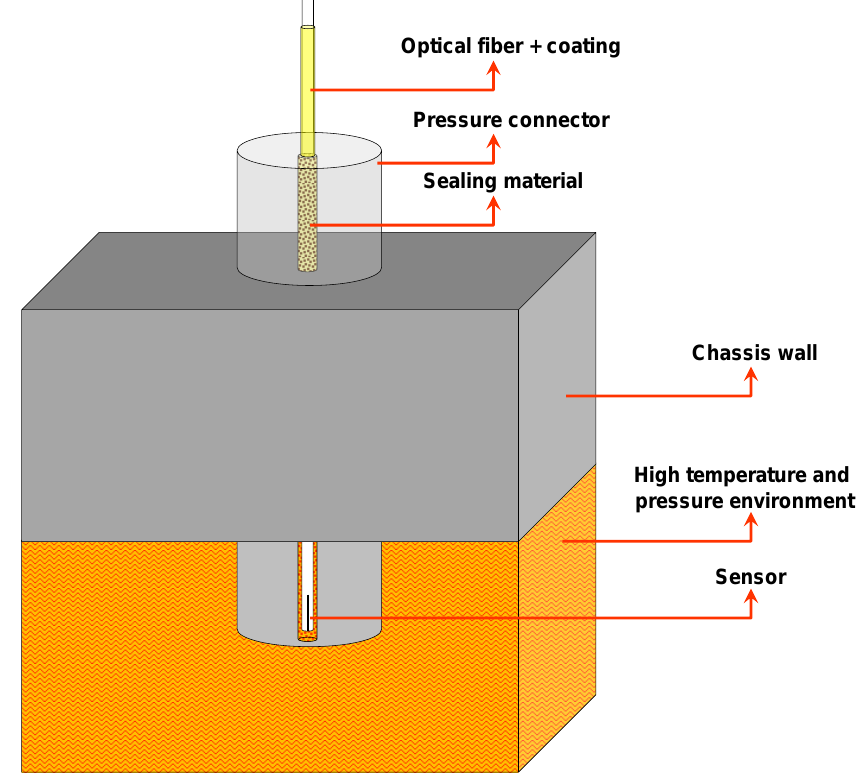
Figure 1. The sealing scheme for the optical fiber sensors.